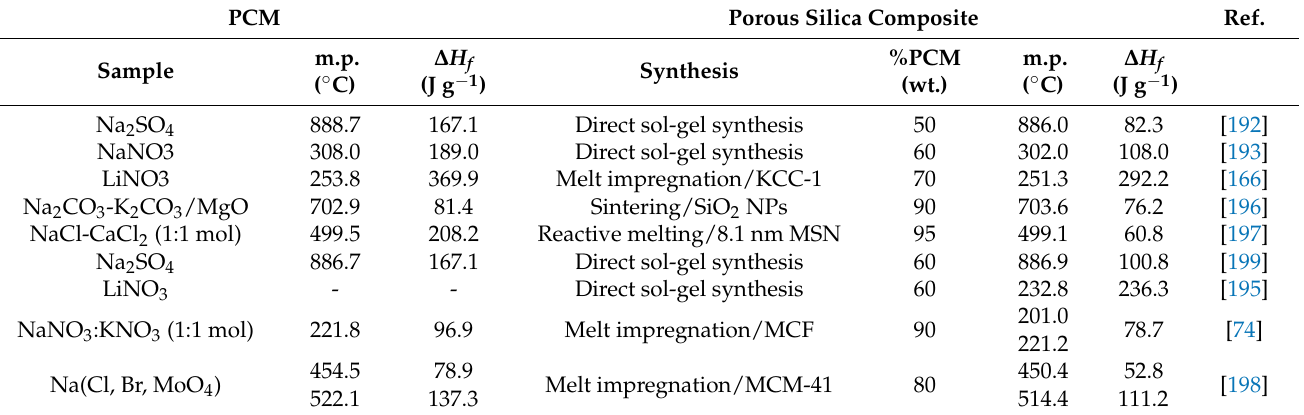
Table 7. Representative molten salt-porous silica composites for thermal energy storage. PCM Porous Silica Composite